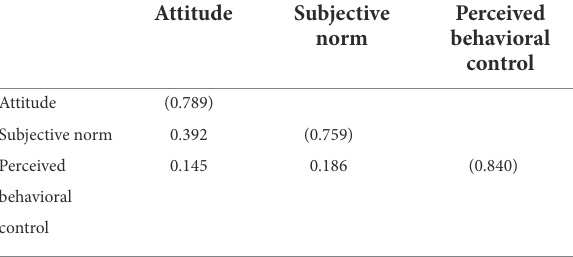
TABLE 6 Correlation coefficient matrix between dimensions and AVE of each dimension.